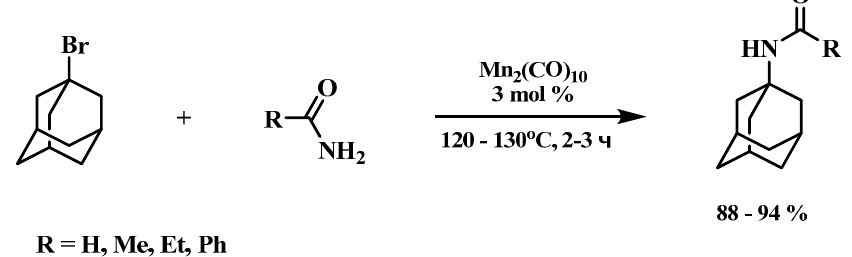
Figure 1. Adamantylation of amides catalyzed by